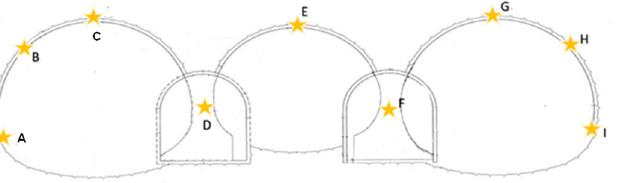
Figure 25. Schematic diagram of the locations of the analyzed pipe roofings and rock bolts.